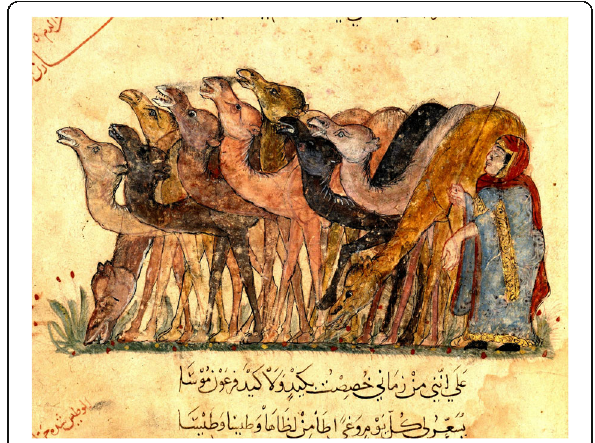
Figure 13 ‘ Herd of camels ’ , Arab miniature by Al-Wasiti from ‘ Maqamat ’ by Al Hariri, thirteenth century, Baghdad (Iraq), showing different